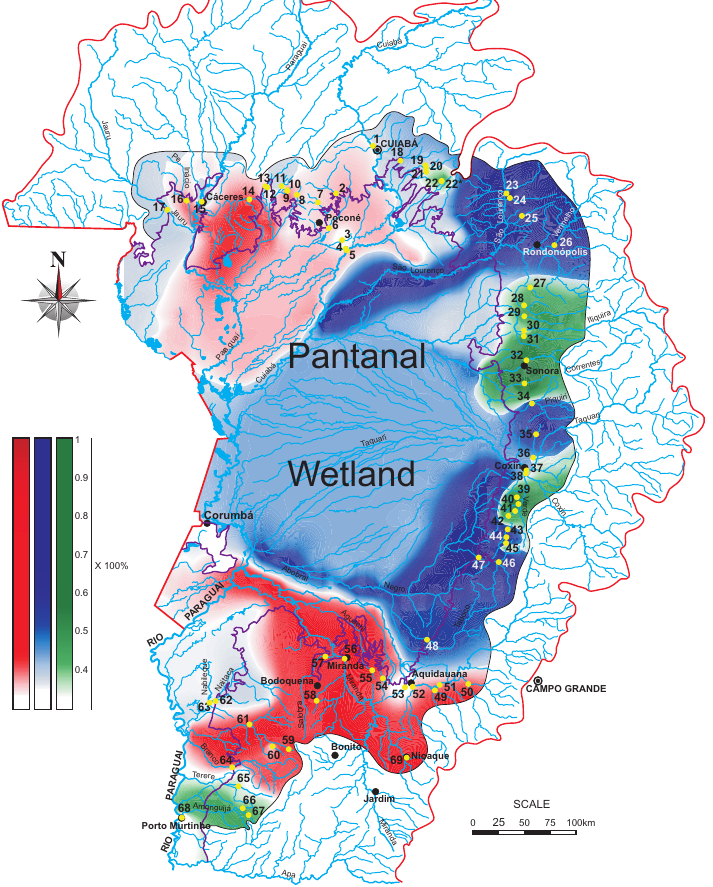
Fig. 10. Extension of the water chemistry in the Pantanal floodplain by simple tributary mixing calculation based on WS sampling (green: end-member 1, blue: end-member 2, red: end-member 3; contributions above 35% are drawn).